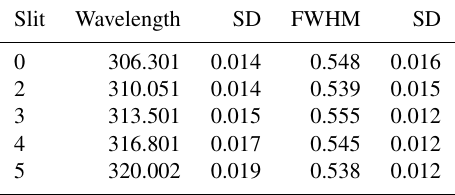
Table 1. Slits and wavelengths used in the Brewer operative algo- rithms. The table provides the mean and the standard deviation of the central wavelengths and the full-width-half-maximum (FWHM) in nanometres of the slits of the “average” Brewer spectrophotome- ter determined during RBCC-E campaigns (Redondas et al., 2014).